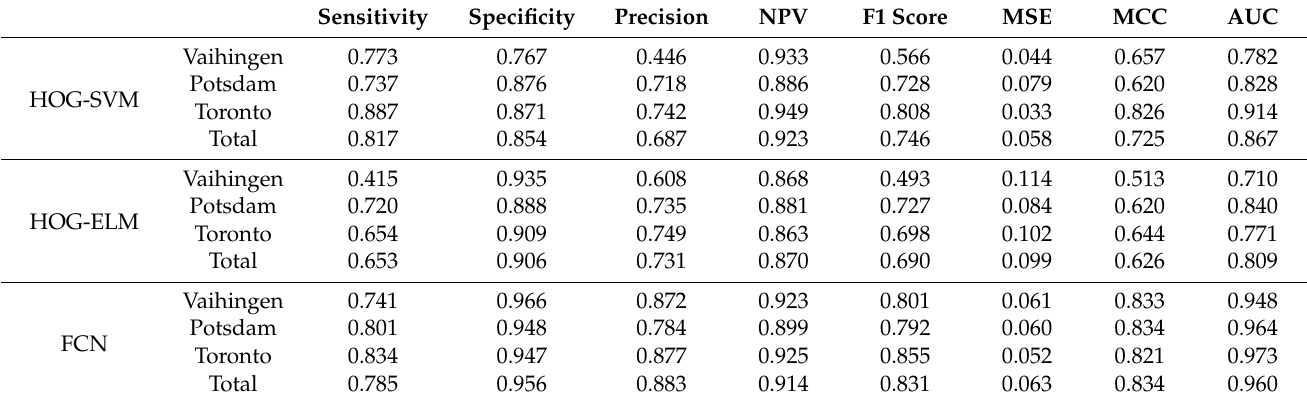
Table 1. Pixel-wise performance by area for the three models: test evaluation